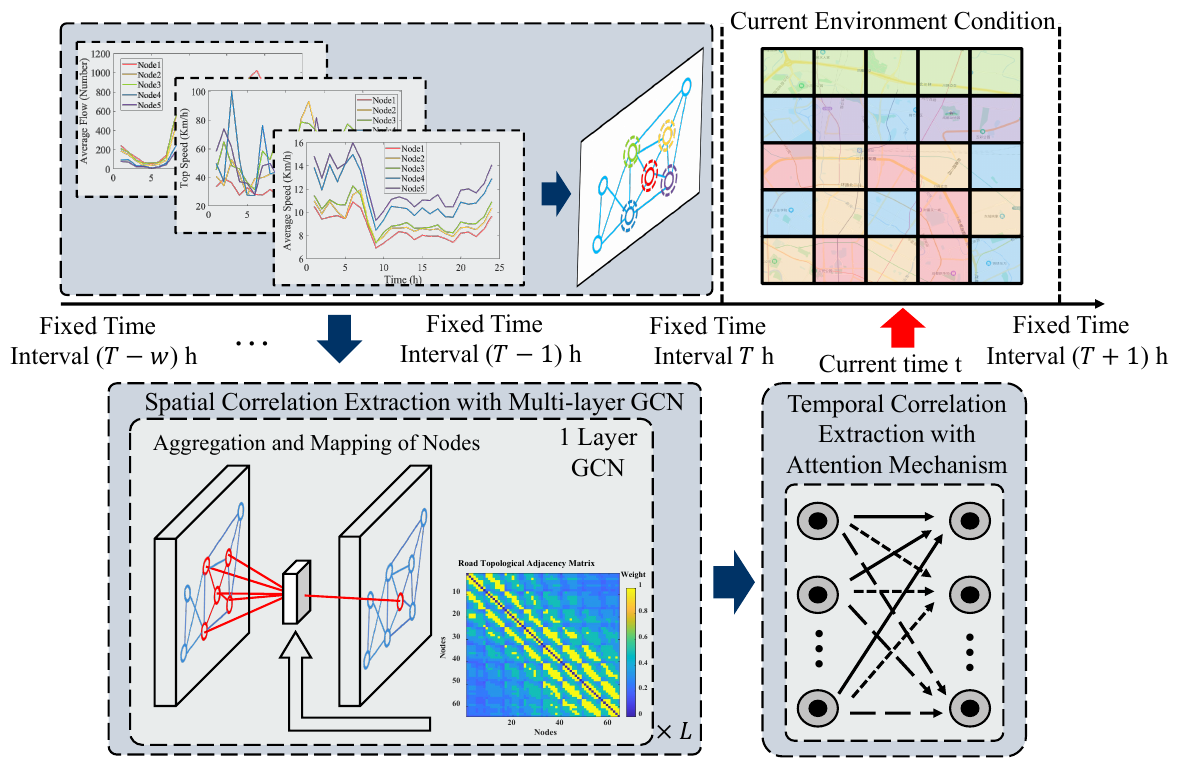
Figure 5. The architecture of the environmental